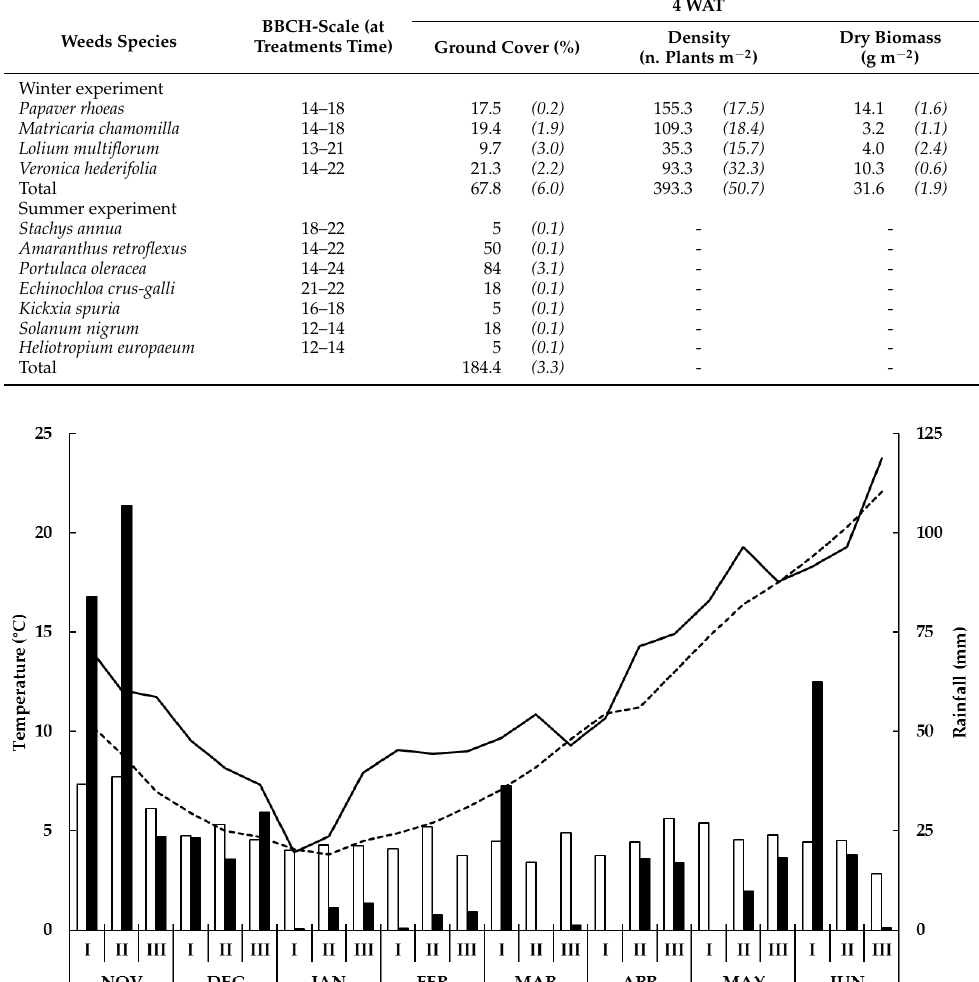
Figure 1. Ten-day mean rainfall (bold bar) and ten-day mean air temperature (continuous line) during the periods of the two experiments (November 2019–June 2020), compared to the ten-day rainfall (empty bar) and ten-day mean air temperature (dashed line) as a multi-annual average (from